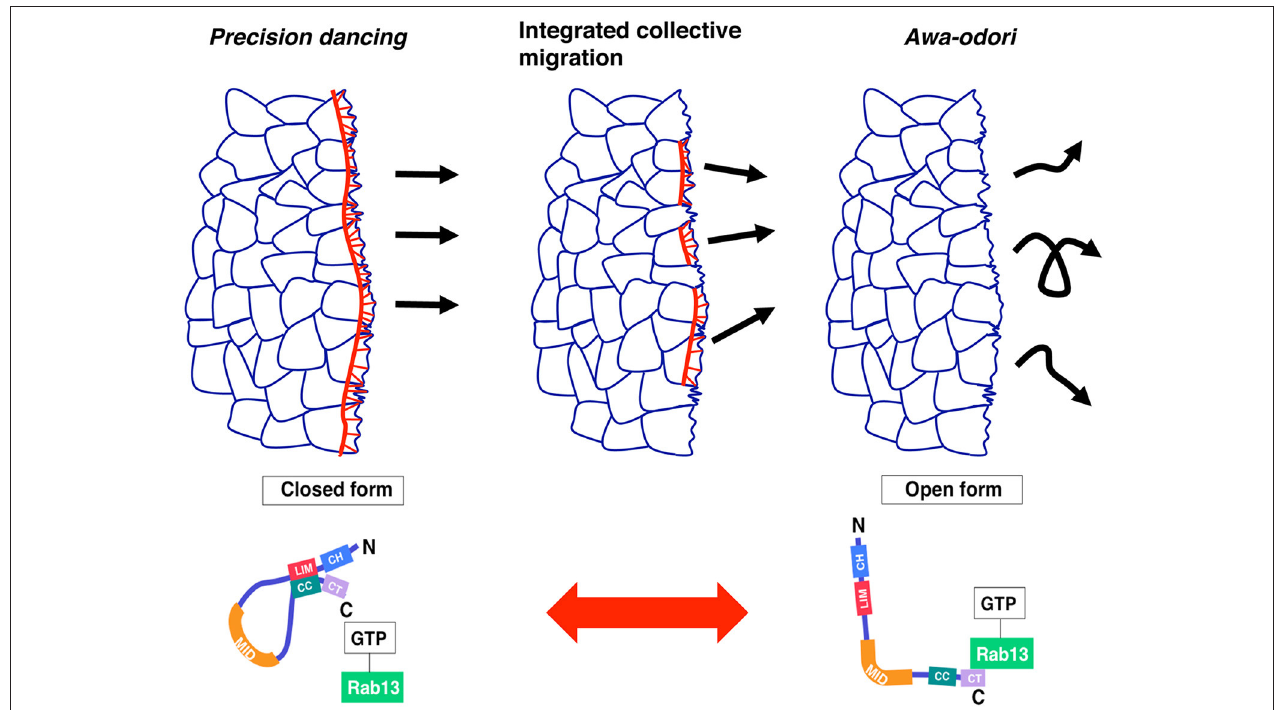
FIGURE 2 | Model: collective cell migration regulated by JRAB/MICAL-L2 conformational plasticity. A cell population expressing only the closed form of JRAB exhibits precision dancing (left), whereas a population expressing only the open form exhibits movement analogous to awa-odori (right). For integrated collective cell migration, JRAB/MICAL-L2 must be able to change its conformation freely depending on the situation (middle). This figure was reproduced from our recent work (Sakane et al., 2016) with permission from ASCB.